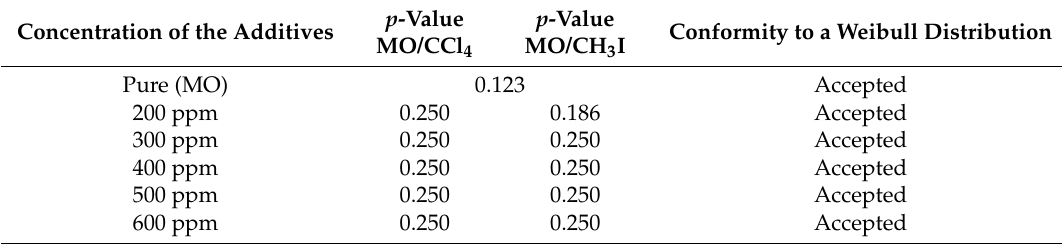
Table 2. The p -value of the mineral oil with various concentrations of CCl4 and CH3I scavenger scavenger additives.